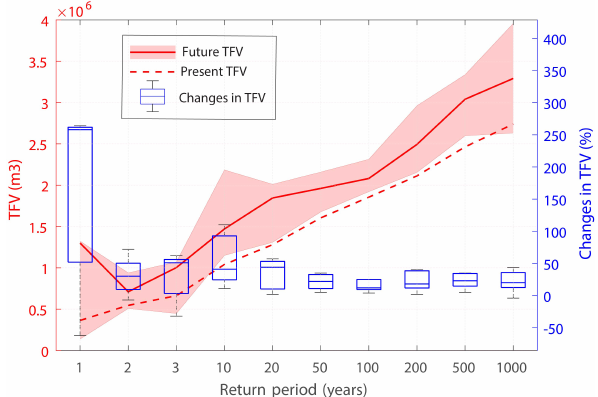
Figure 3. Changes in total flood volume (TFV) as a function of pre- cipitation intensity at various return periods under RCP8.5 scenario without mitigation and adaptation. The red solid line represents the multi-model ensemble median TFV with shaded areas denoting the ensemble range. The red dashed line is the TFV under present con- dition. Box plots show the relative changes in TFV by 2020–2040 relative to present condition. Box edges illustrate the 25th and 75th percentile, the central mark is the median, and whiskers mark the 5th and 95th percentiles.